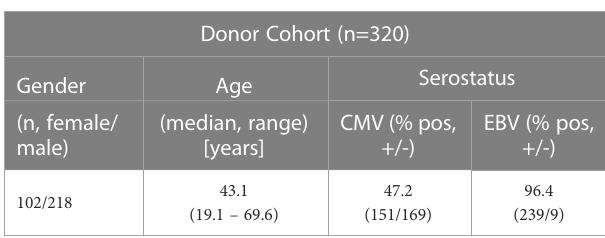
TABLE 1 Description of the healthy donor